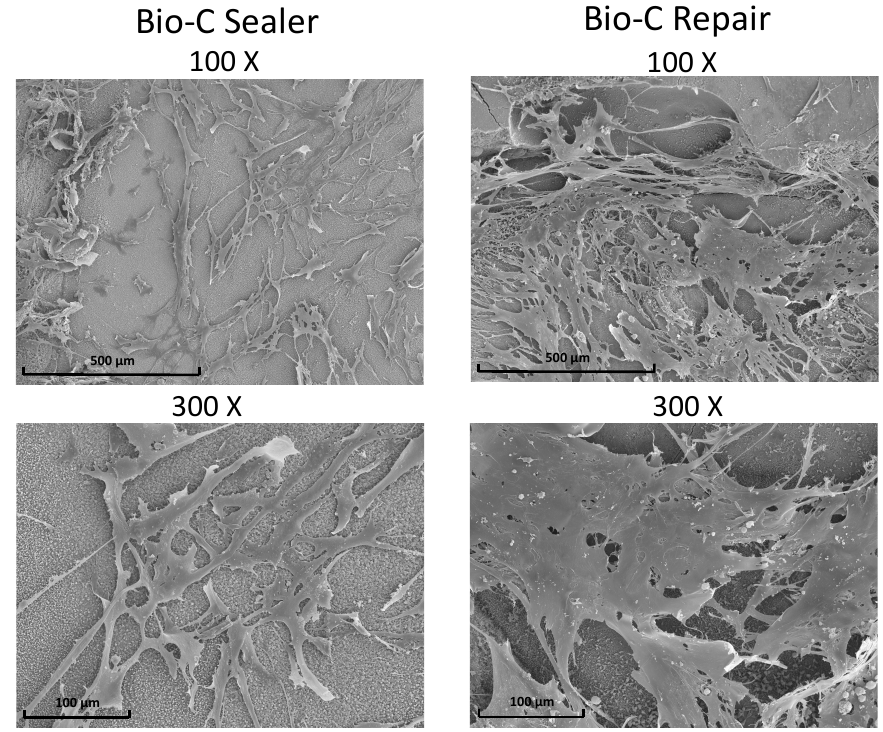
Figure 5. Scanning electron microscopic photomicrographs showing morphological aspects of h PDLSCs on discs of Bio-C Sealer and Bio-C Repair at 72 hours. Scale bar: 500 μ m and 100 μ m. Magnification: 100× and 300×.